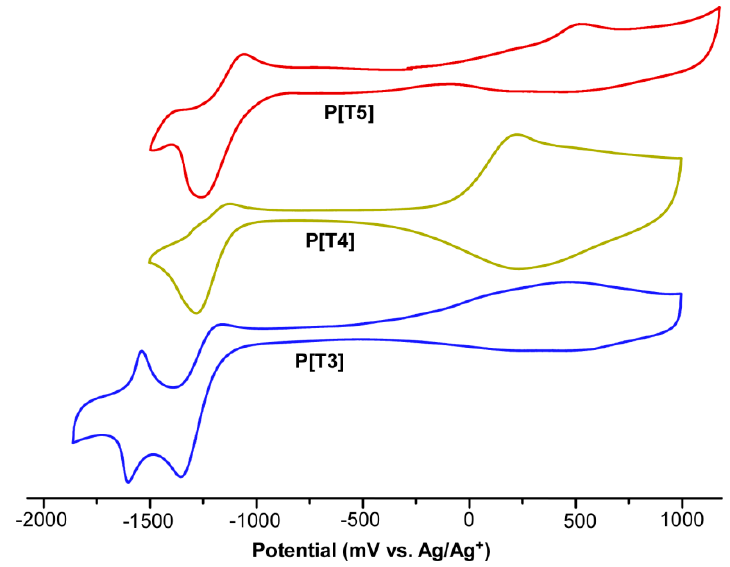
Table 3. Electrochemical data for polymer films of P[T1] – P[T5] . 1